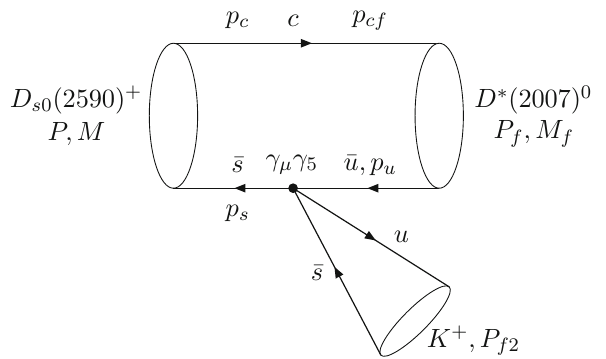
Fig. 3 Feynman diagram for decay D s 0 ( 2590 ) + → D ∗ ( 2007 ) 0 K + after reduction